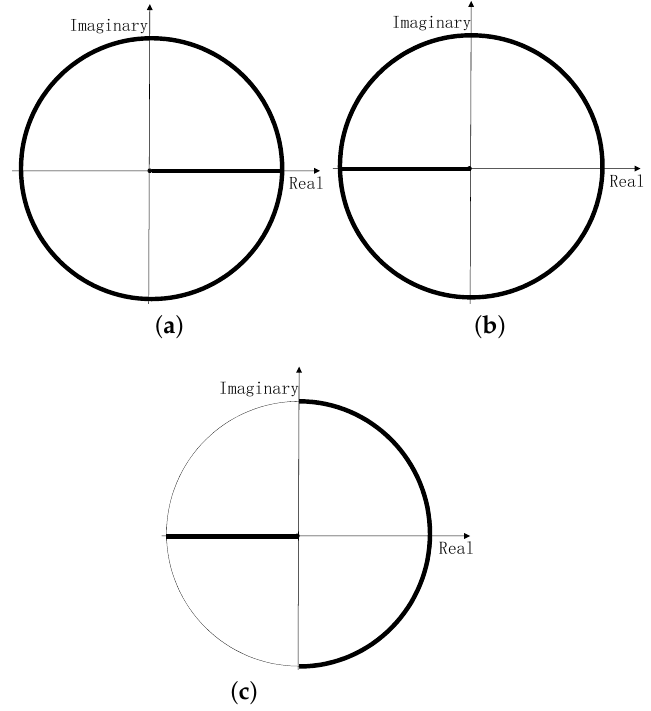
Figure 2. Three subsets: ( a ) I ∪ O , ( b ) [ − 1, 0] ∪ O ( c ) [ − 1, 0] ∪ V